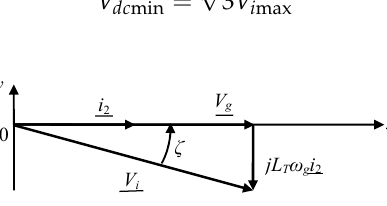
Figure 3. Fresnel diagram characterizing the operation of the LCL